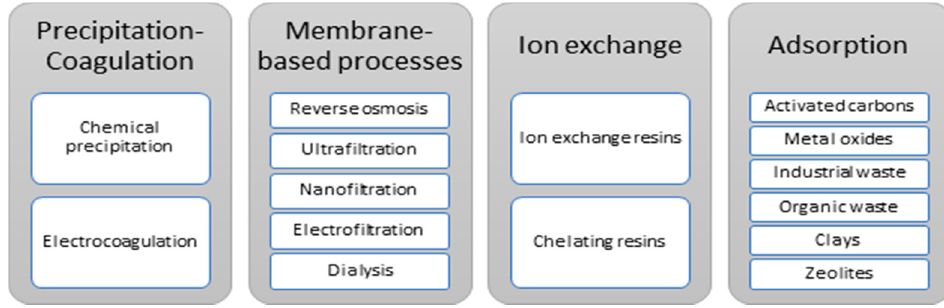
Figure 1. Technologies used for the removal of As and F − in drinking water.